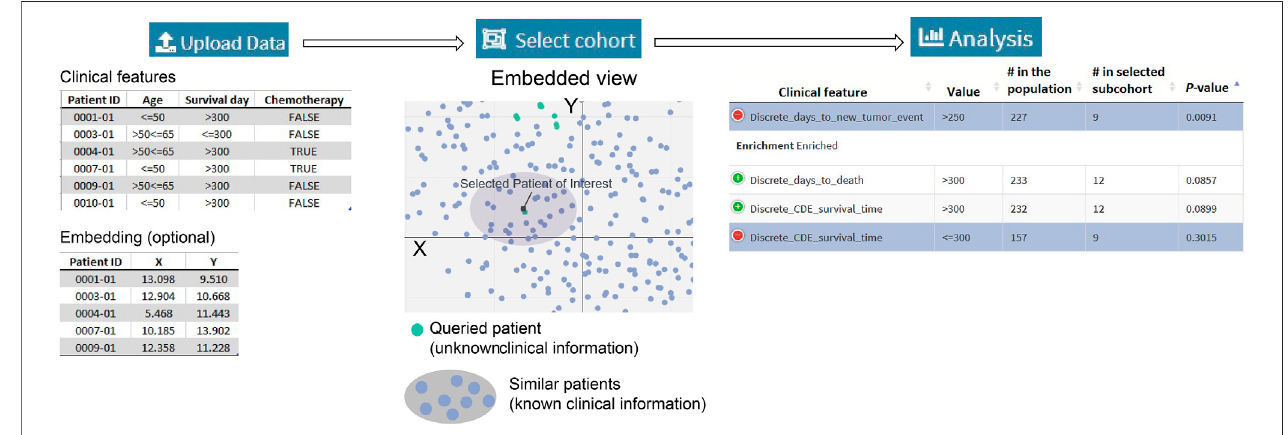
FIGURE 1 | Overview of data processing and